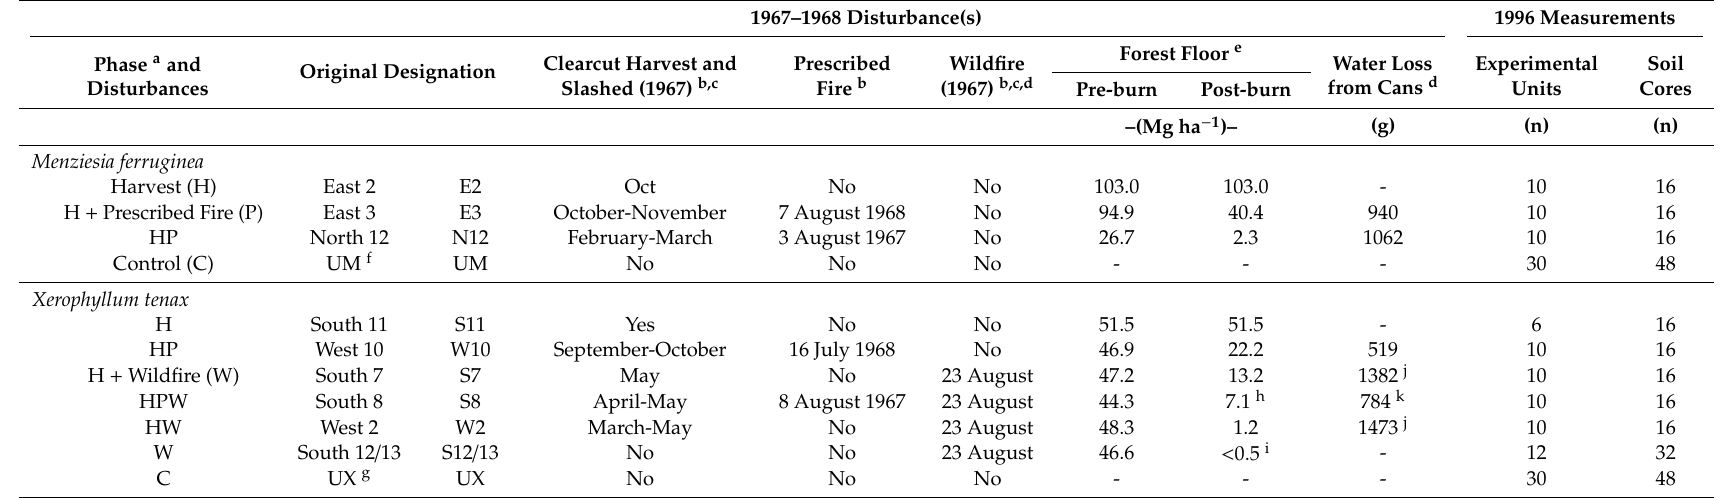
Table 1. Designations and descriptions of original Miller Creek Demonstration Forest sites in northwestern Montana, USA, including the timing of harvest and fire events, forest floor levels immediately before and after disturbance(s), and numbers of experimental units and soil cores per resulting disturbance category.